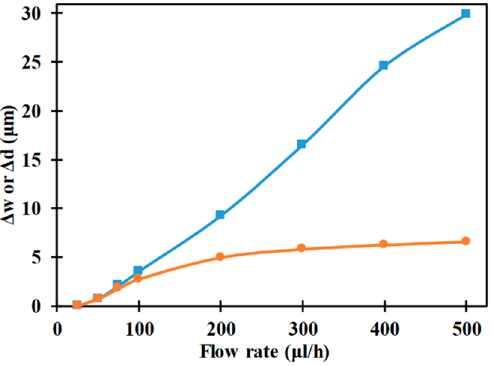
Figure 7. Variation of Δ w ( ■ ) and Δ d ( ● ) with flow rare ( r p = 2 μ m, L e = 2000 μ m, L ch = 2200 μ m, W e